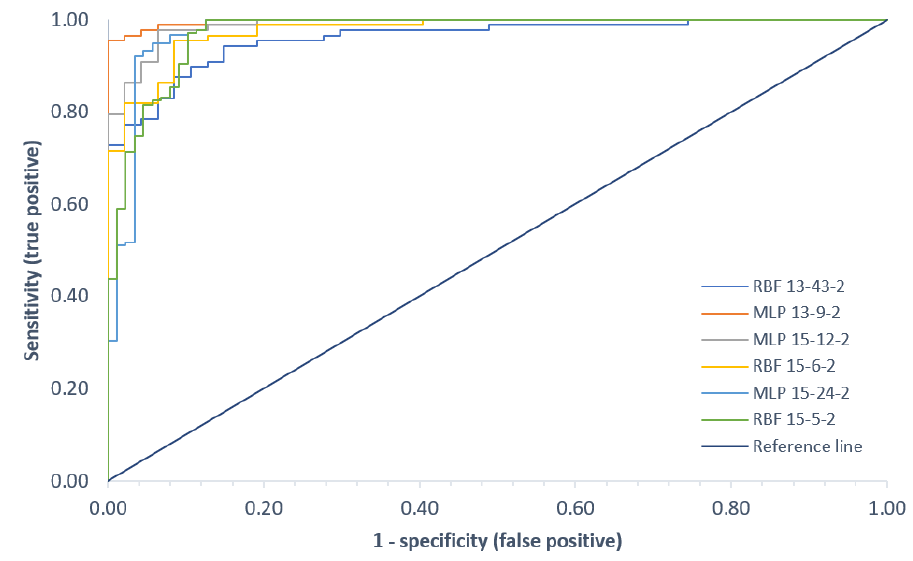
Figure 11. Comparison of the ROC curves for all classification variants. Table 4. Area under the ROC curves and ROC threshold.